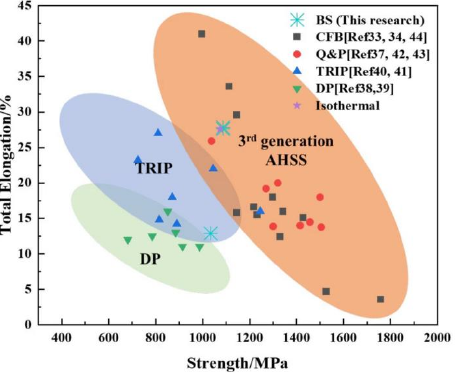
Figure 7. Performances of the designed CFB steels, compared to TRIP, DP, and 3rd generation AHSS in [33,34,36–44] and the isothermal sample (holding at 400 °C for an hour).